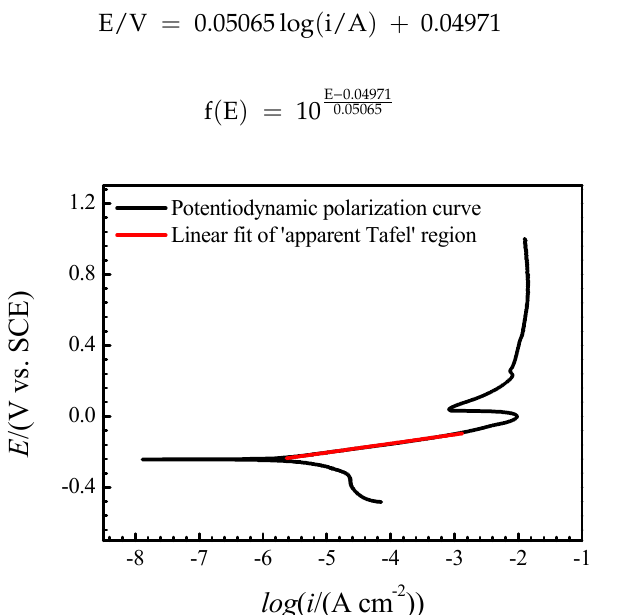
Figure 6. Potentiodynamic polarization curve of the copper electrode in neutral 3.5% (wt.) NaCl solution at room temperature and the linear fit of the ‘apparent Tafel’ region.